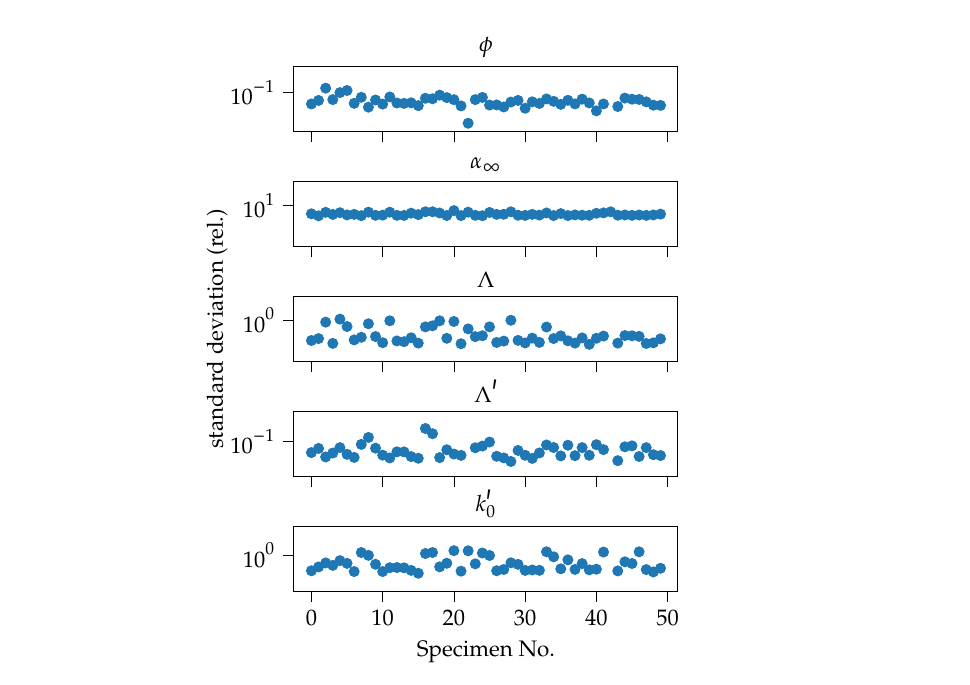
Figure A3. Relative standard deviation for the data augmentation procedure. The standard deviation is computed for all ten runs of the inverse parameter estimates for each specimen and normalized by the mean of the ten runs. It can be seen, that the data varies about approx. 10% for most Biot parameters.